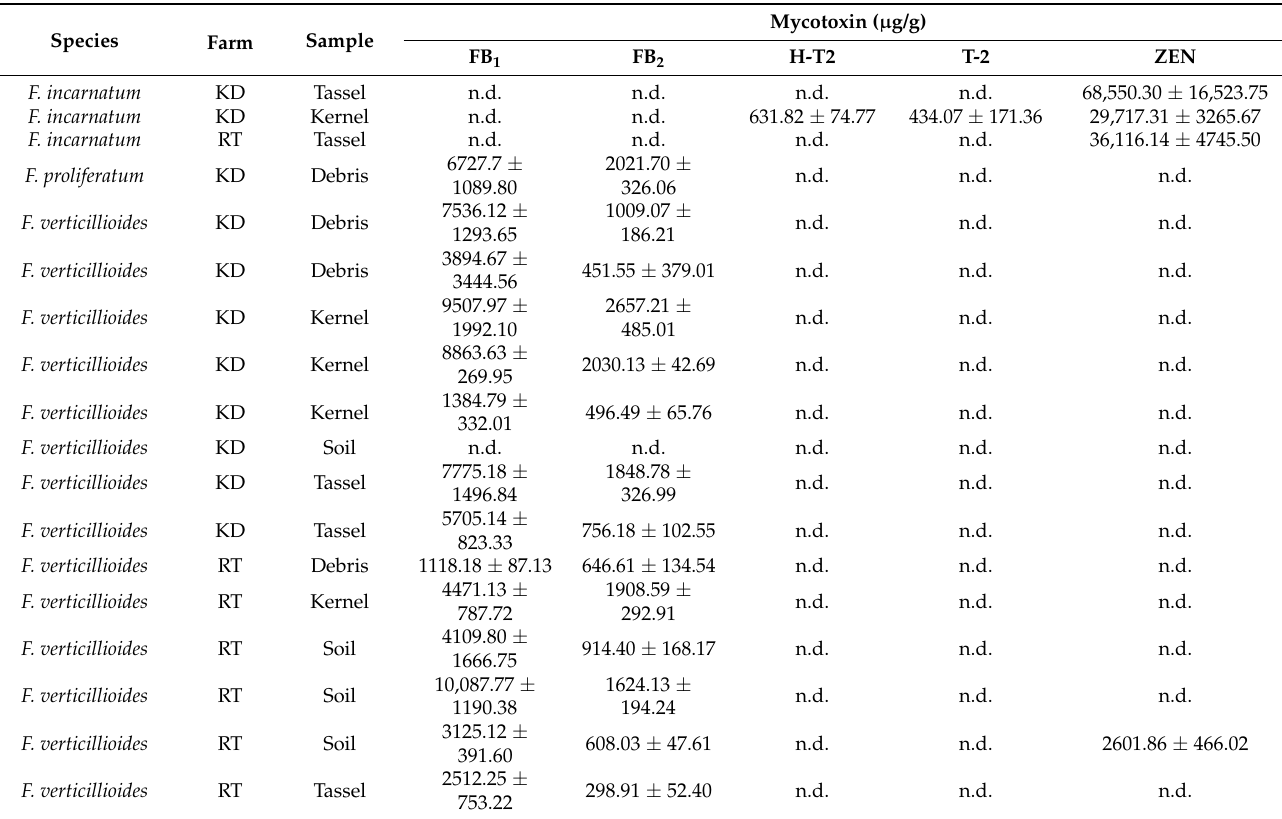
Table 5. Fumonisins, trichothecenes A, and zearalenone ( µ g/g) production by Fusarium spp. isolates recovered from Kampong Dadong and Rhu Tapai grain corn farms in